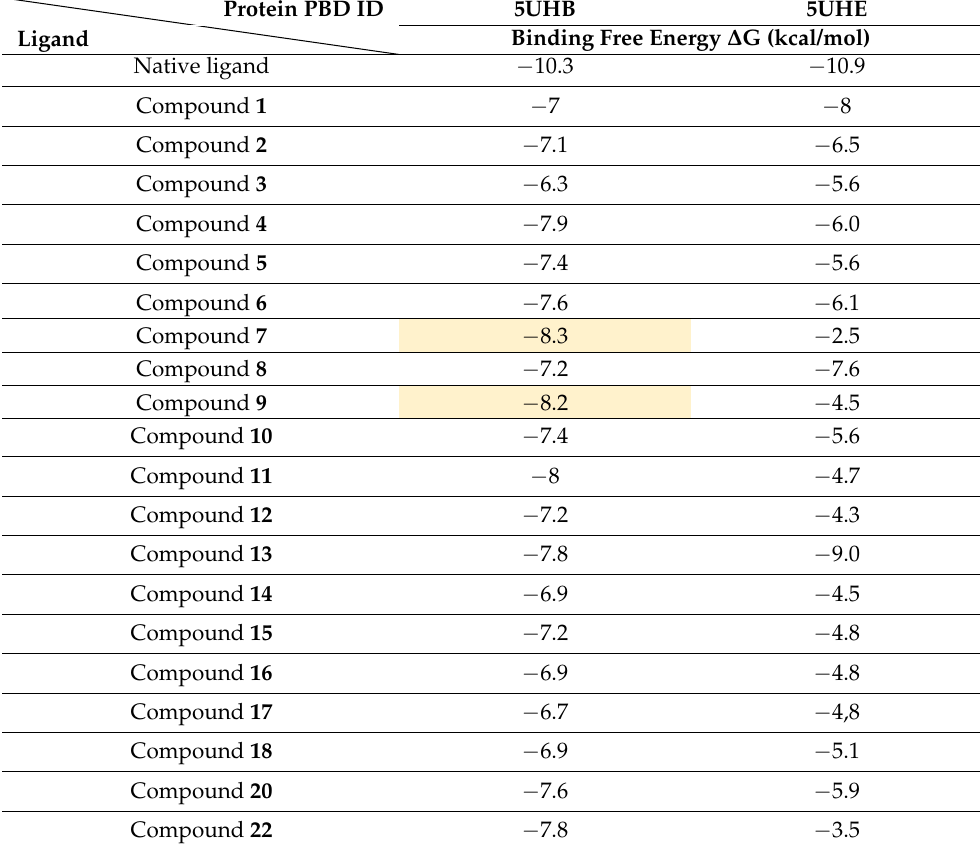
Table 4. Recorded docking scores (binding energy, ∆ G kcal/mol) for compounds 1–18 , 20 , and 22 . The top 2 ranked active compounds are